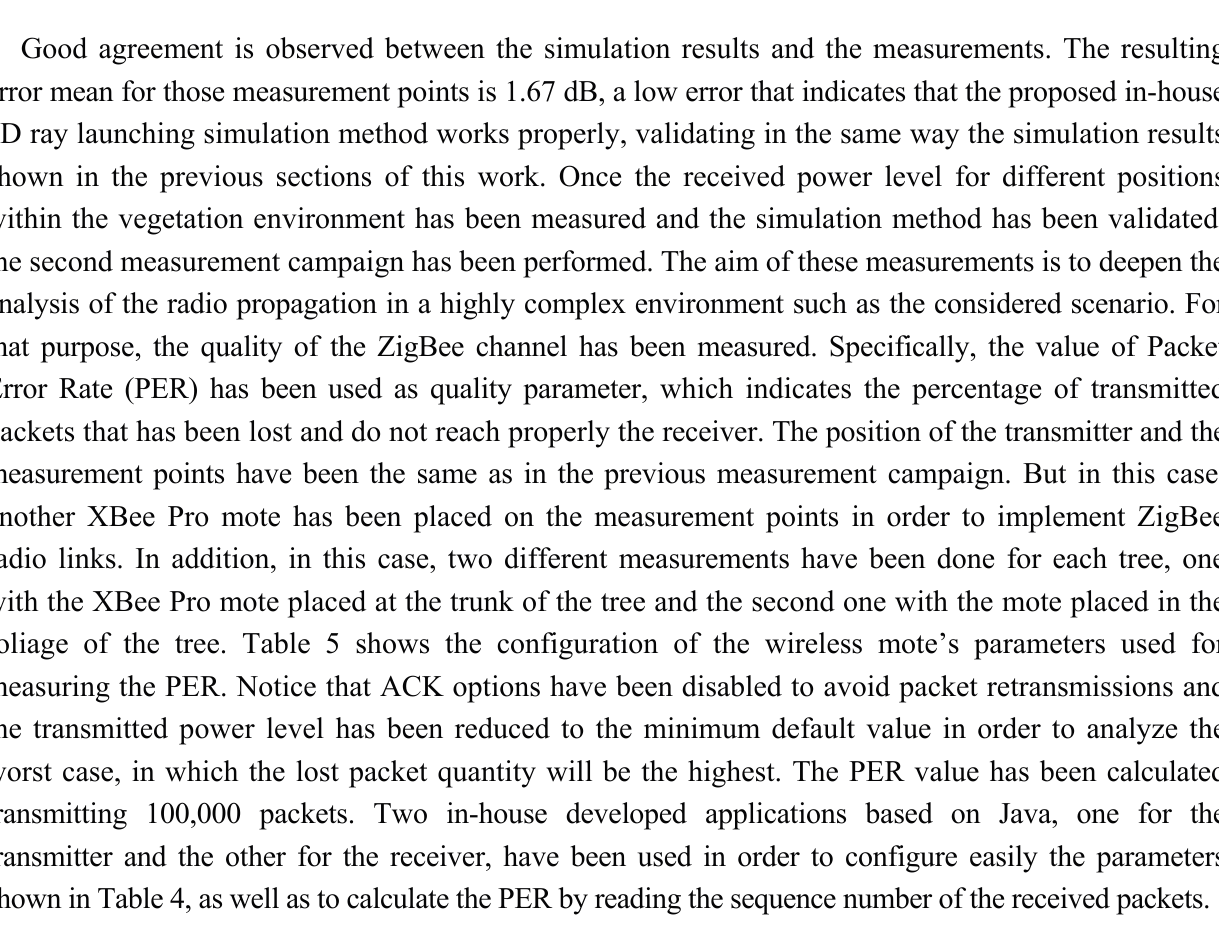
Table 5. Configuration of the parameters of the XBee Pro wireless devices to measure the ZigBee radio link